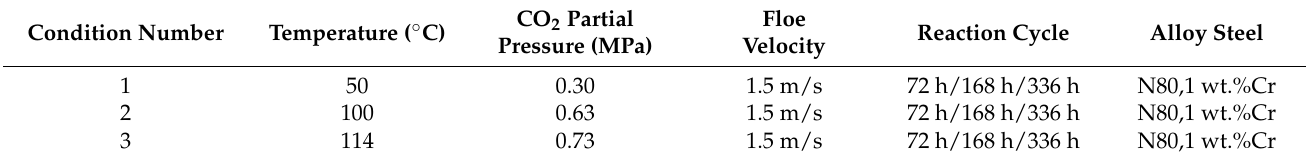
Table 2. Experimental test